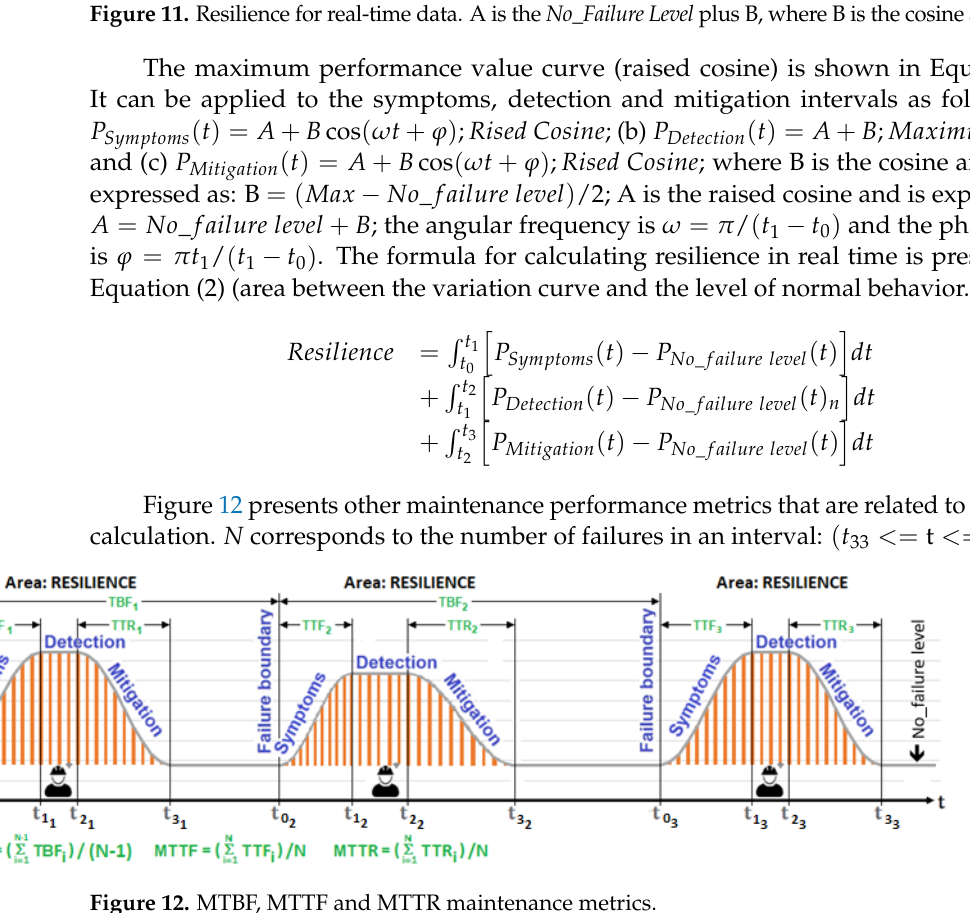
Figure 11. Resilience for real-time data. A is the No_Failure Level plus B, where B is the cosine am- plitude.